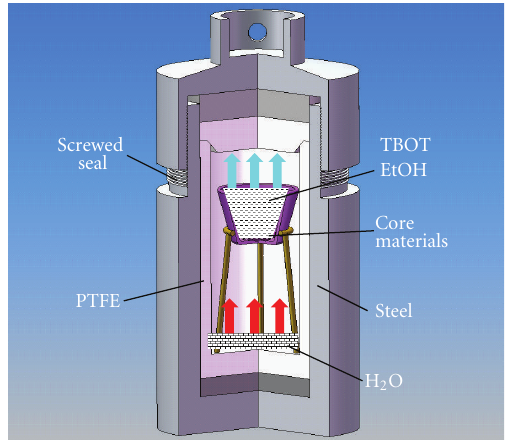
Figure 1: The setup of the vapor phase hydrolysis